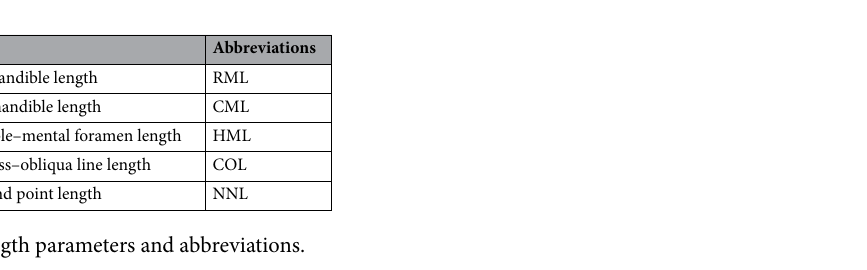
Figure 5. ( A ) Sagittal, transversal and coronal images brought to orthogonal plane, ( B ) Overlapped image.